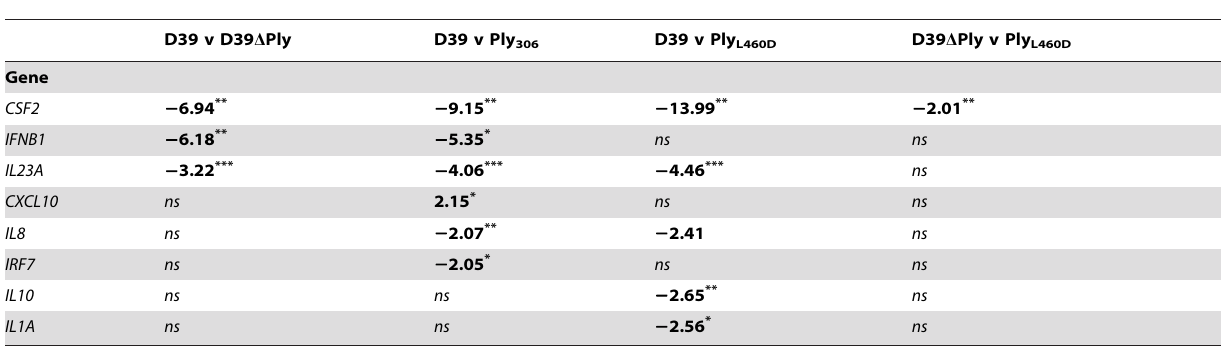
Table 2. Ply-dependent changes in expression in the D39 background.